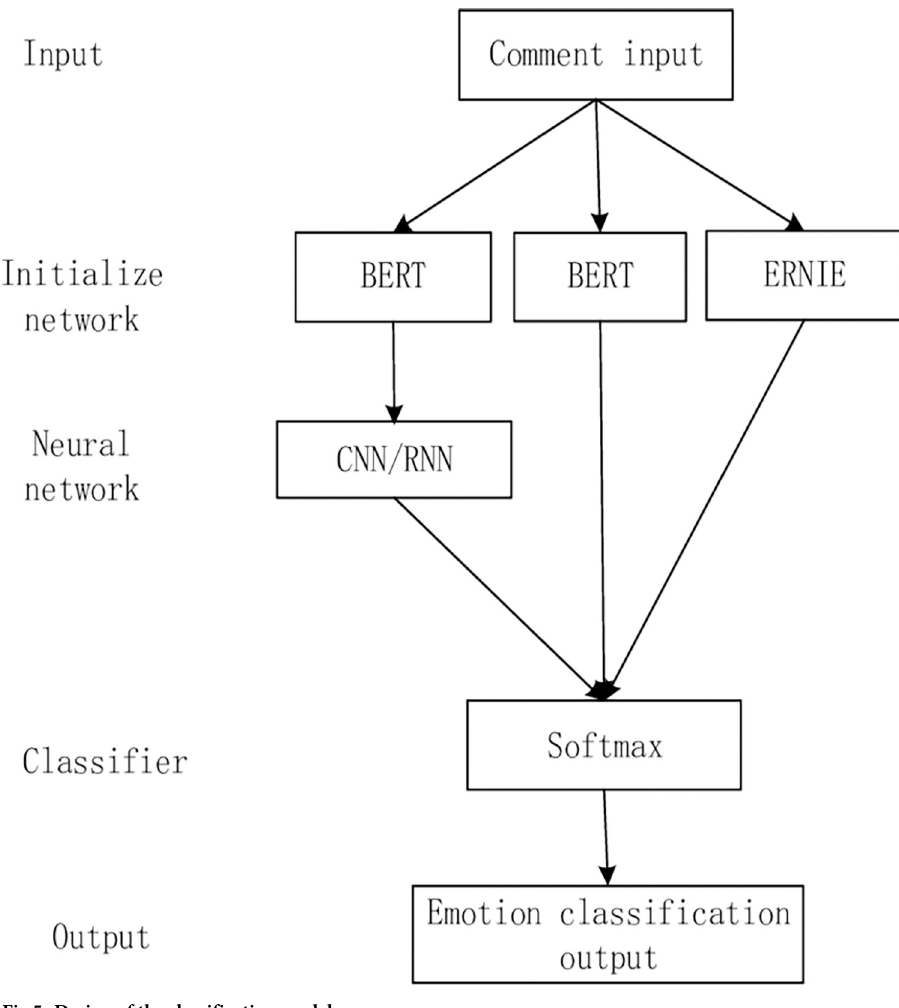
Fig 5. Design of the classification model.